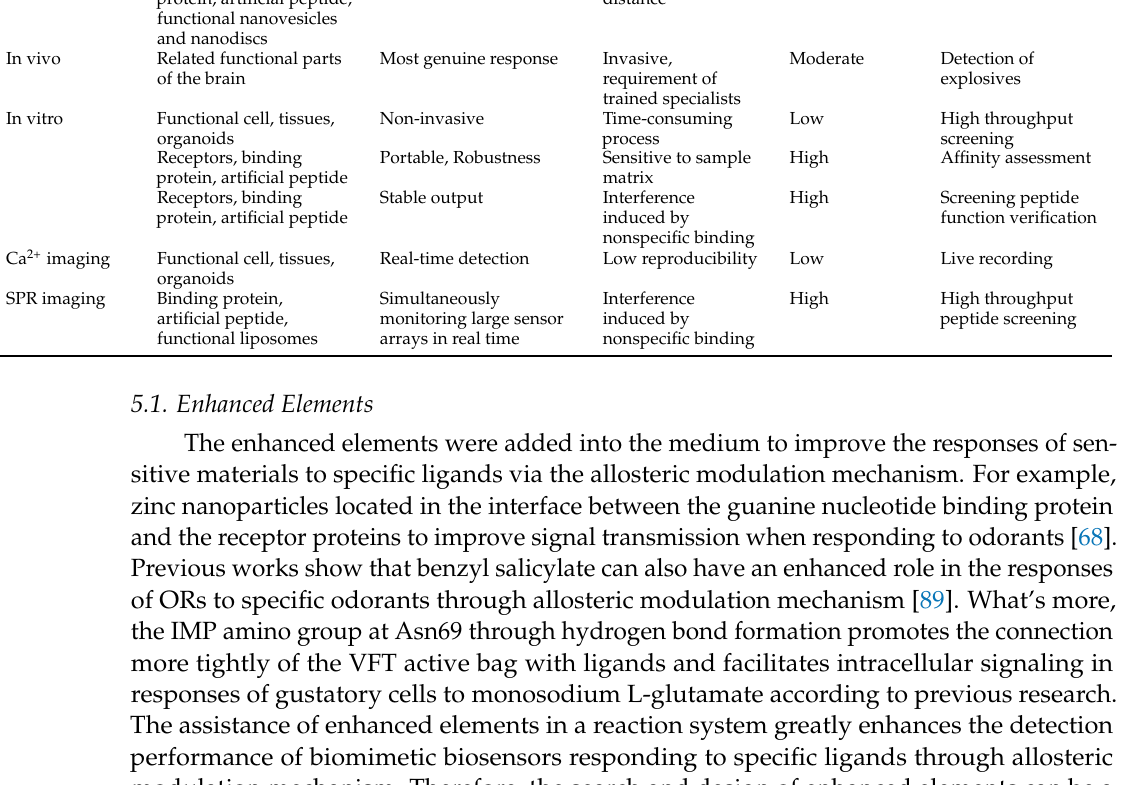
Portable Most Development Possibilities